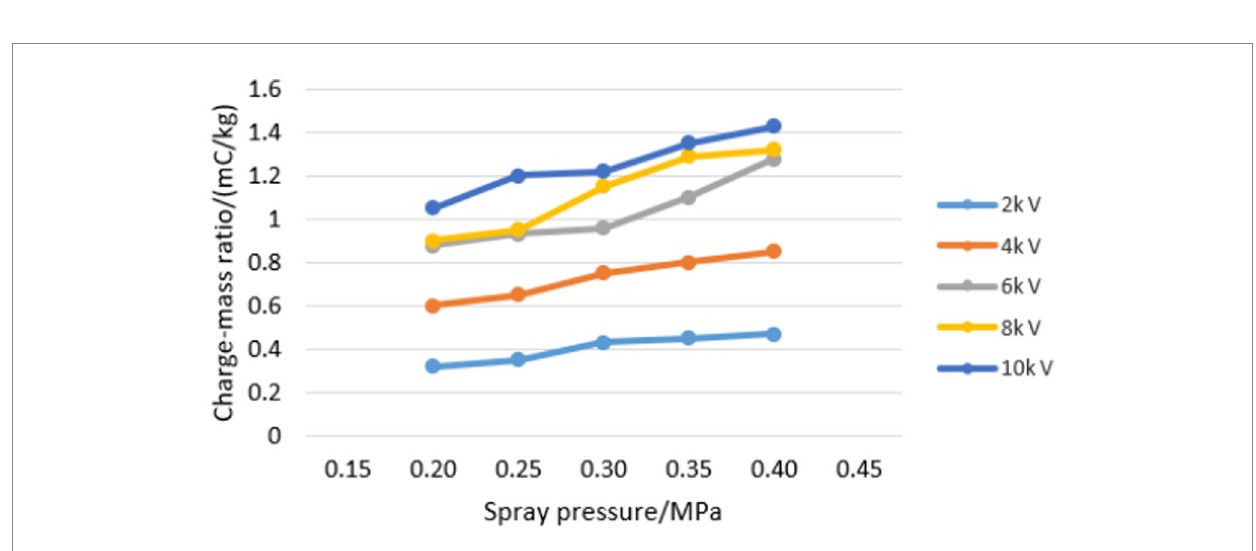
FIGURE 8 Experimental results of the effect of spray pressure on charge mass